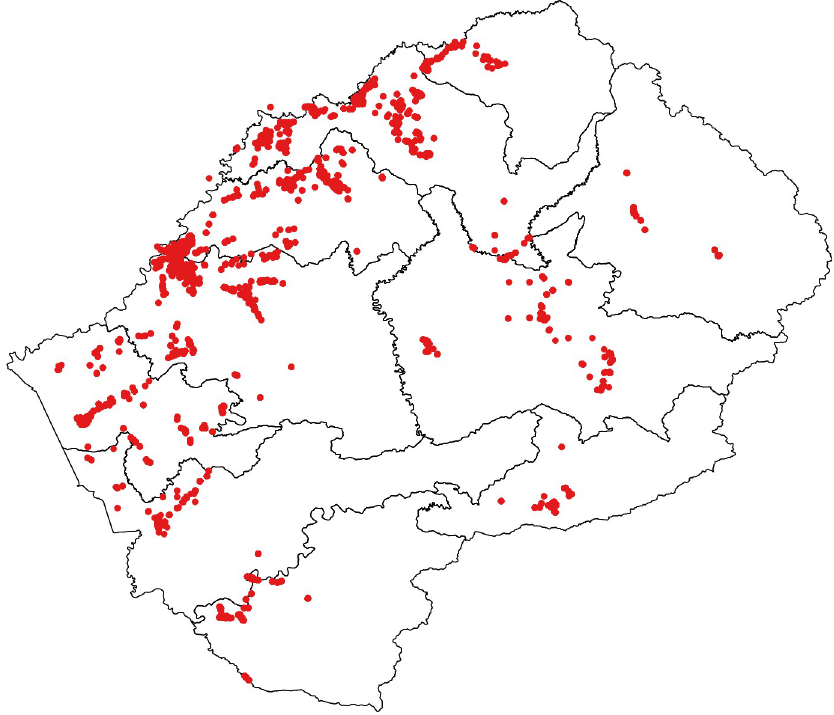
Fig 1. Lesotho national tuberculosis prevalence survey map. Black lines delineate provinces and red dots represent households of the enumerated survey population.